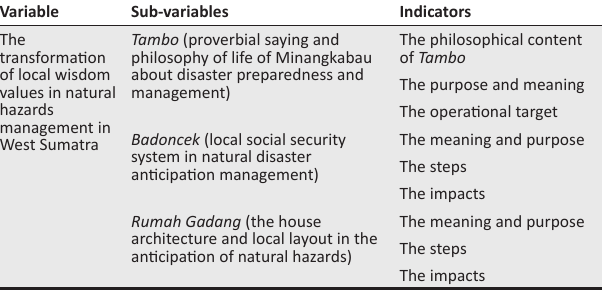
TABLE 1: Local wisdom in West Sumatra local